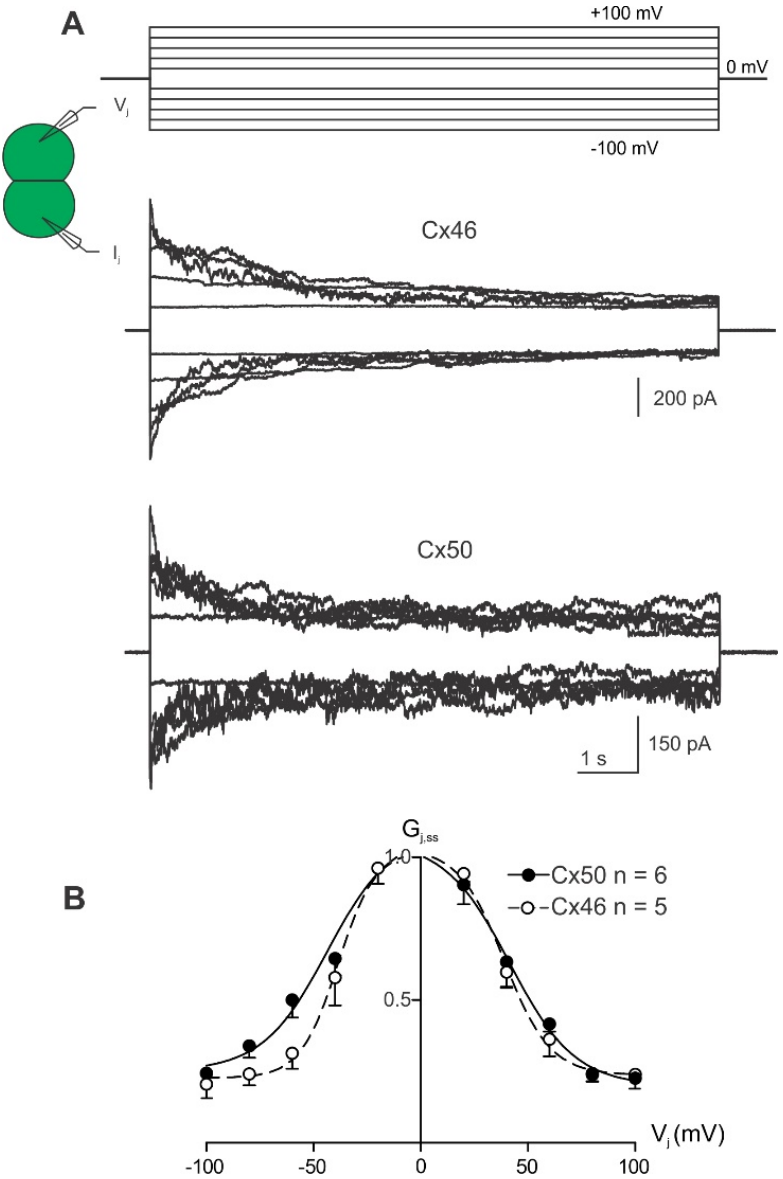
Figure 3. V j -gating of homotypic Cx46 and Cx50 gap junction channels. ( A ) Superimposed junctional currents (I j s) from cell pairs expressing wild-type Cx46 or Cx50 in response to a series of voltage pulses (V j s) ranging from ± 20 to ± 100 mV in 20 mV increments as shown at the top. ( B ) Normalized steady-state junctional conductance (G j,ss ) was plotted against the tested V j range for Cx46 (open circles) and Cx50 (solid circles) GJs. A Boltzmann equation was used to fit the G j,ss –V j plot of Cx46 (smooth dashed grey lines) and Cx50 (smooth solid grey lines). Error bars represent SD. Number of cell pairs analyzed are indicated.